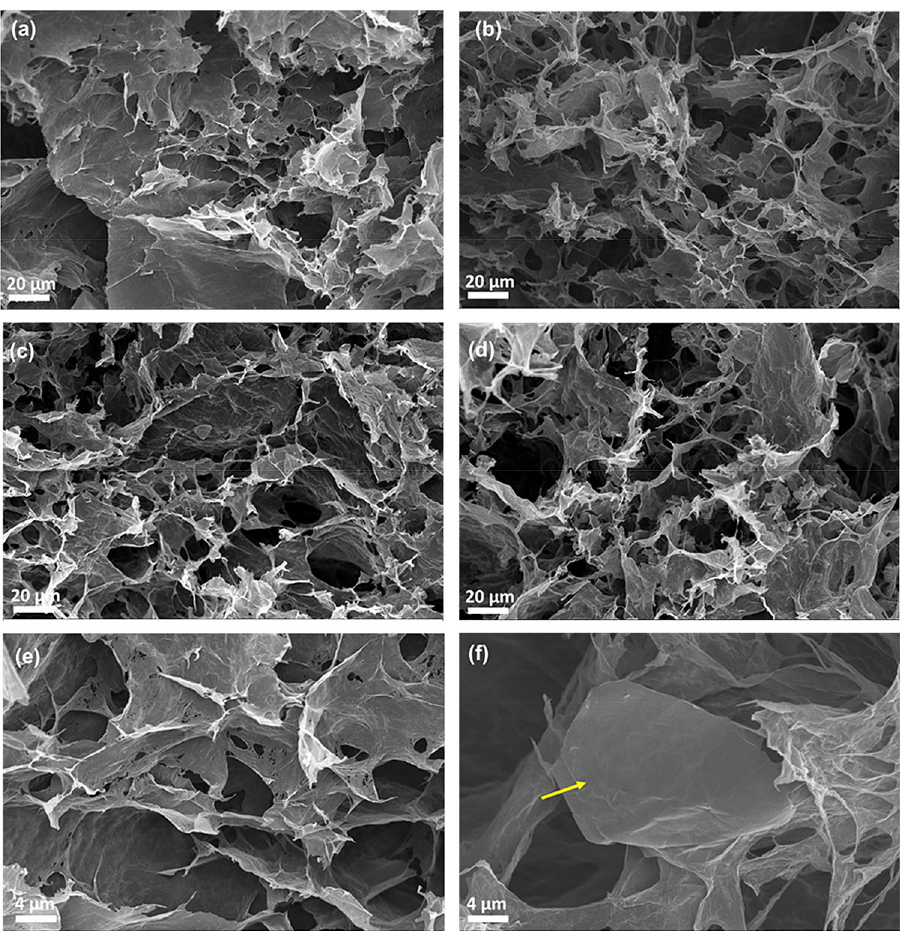
Figure 4. SEM images of the ( a ) rGO aerogel, ( b ) 90/10 HA, ( c ) 70/30 HA and ( d ) 50/50 HA. In ( e ) a zoom of the rGO aerogel is presented and in ( f ) a zoon of hybrid aerogel which clearly show the presence of hBN platelets in the HA samples and have size of a few microns in length and about ~ 3–5 microns thickness. The scale bar is 20 μm for ( a – d ) while for ( e , f ) is 4